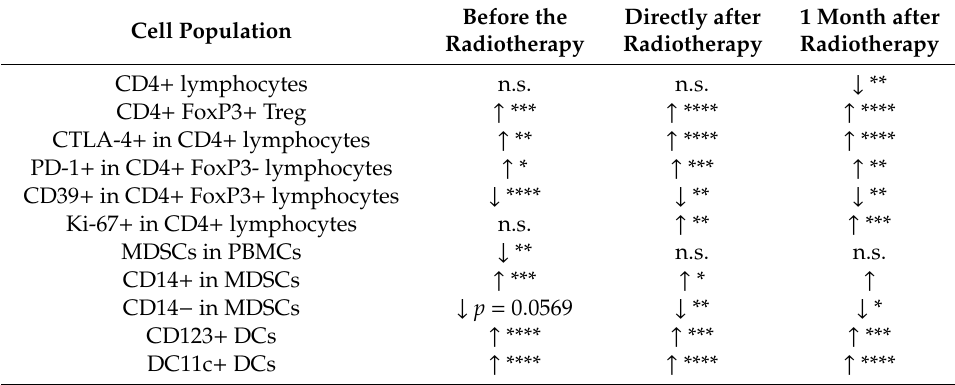
Before the Directly after 1 Month after Radiotherapy Radiotherapy Radiotherapy